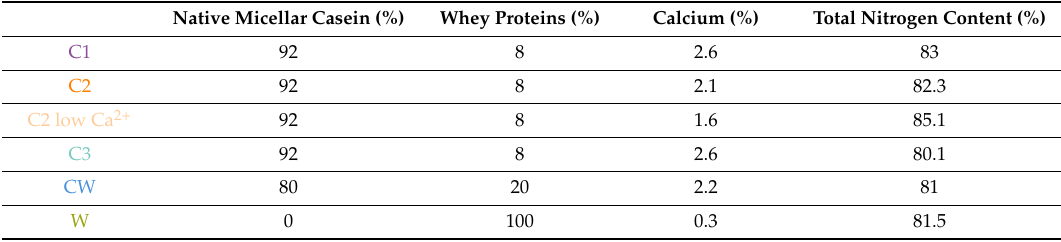
Table 1. Characteristics of the milk